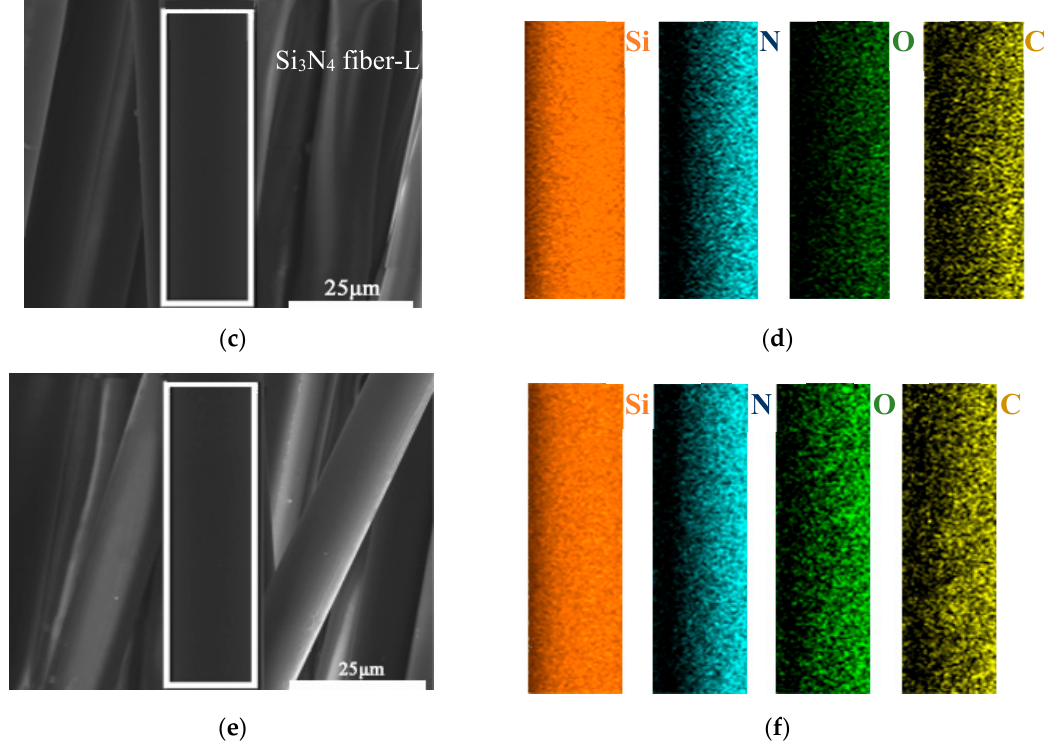
Figure 2. ( a ) Surface SEM images of Si 3 N 4 fiber-L and ( b ) Si 3 N 4 fiber-H, ( c , d ) scanning electron microscopy and energy dispersive pectroscopy (SEM-EDS) element mapping of Si 3 N 4 fiber-L and ( e , f ) Si 3 N 4 fiber-H.